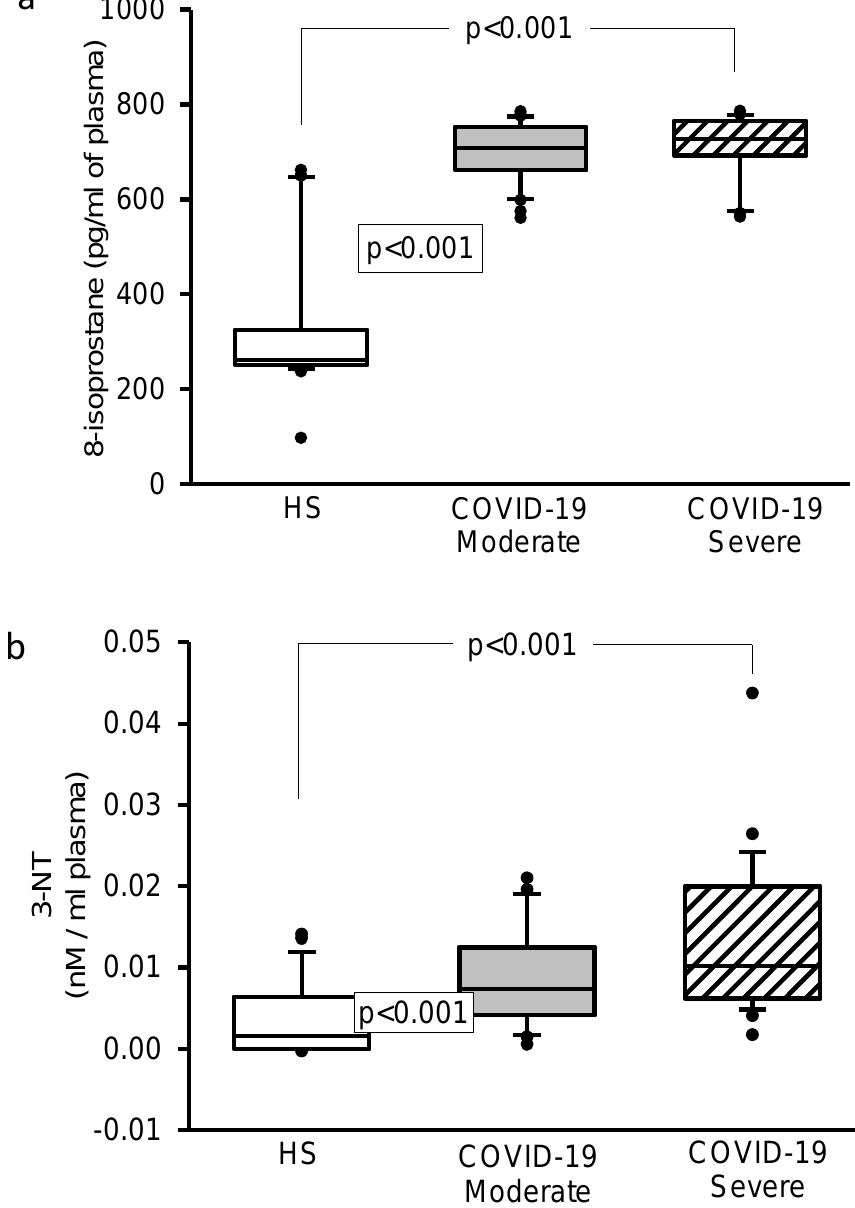
Figure 2. ( a ) The 8-isoprostane concentrations statistically increased in both the moderate and severe COVID-19 patients in comparison with HS. ( b ) 3-NT statistically increased in the moderate and severe COVID-19 patients in comparison to HS. Abbreviations: HS = healthy subjects, 3-NT = 3-nitrotyrosine.